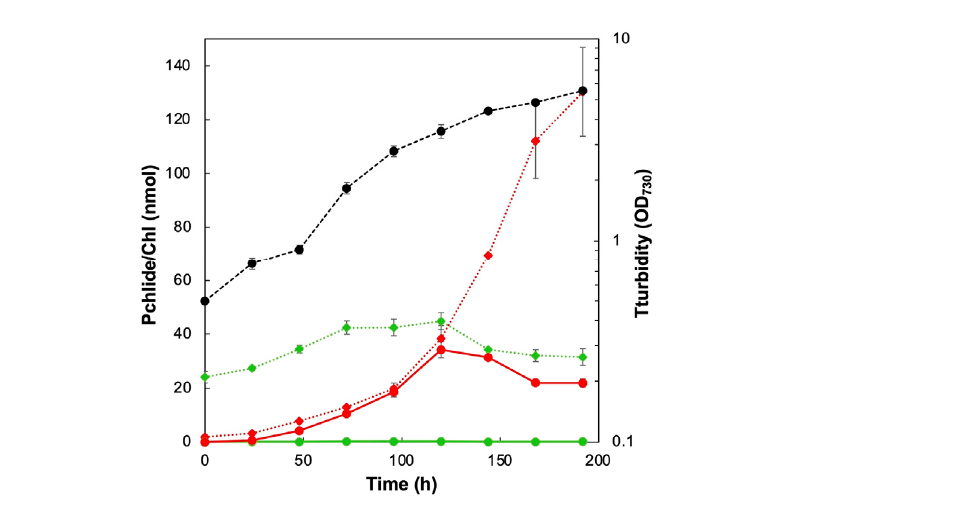
Figure 2. Pchlide accumulation of YFC2 during heterotrophic growth in the dark. Filled black circles indicate the turbidity (OD 730 ). Chl (green) and Pchlide (red) contents in the culture media (circles, solid lines) and cells (diamonds, dotted lines) in 10 mL.